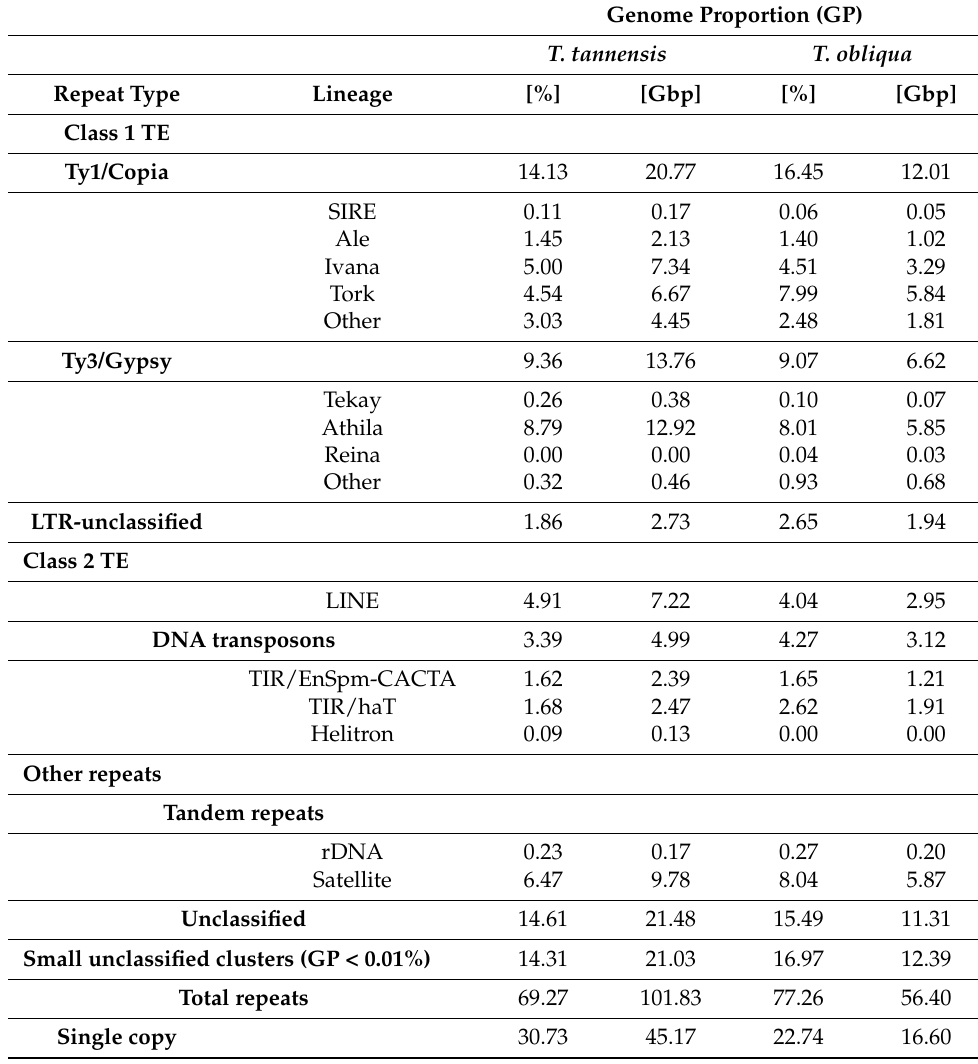
Table 1. Repetitive DNA composition estimated in the individuals of T. tannensis and T. obliqua analyzed. Gbp = giga base pairs; TE = transposable element; rDNA = ribosomal DNA. Genome Proportion (GP) T. tannensis T. obliqua